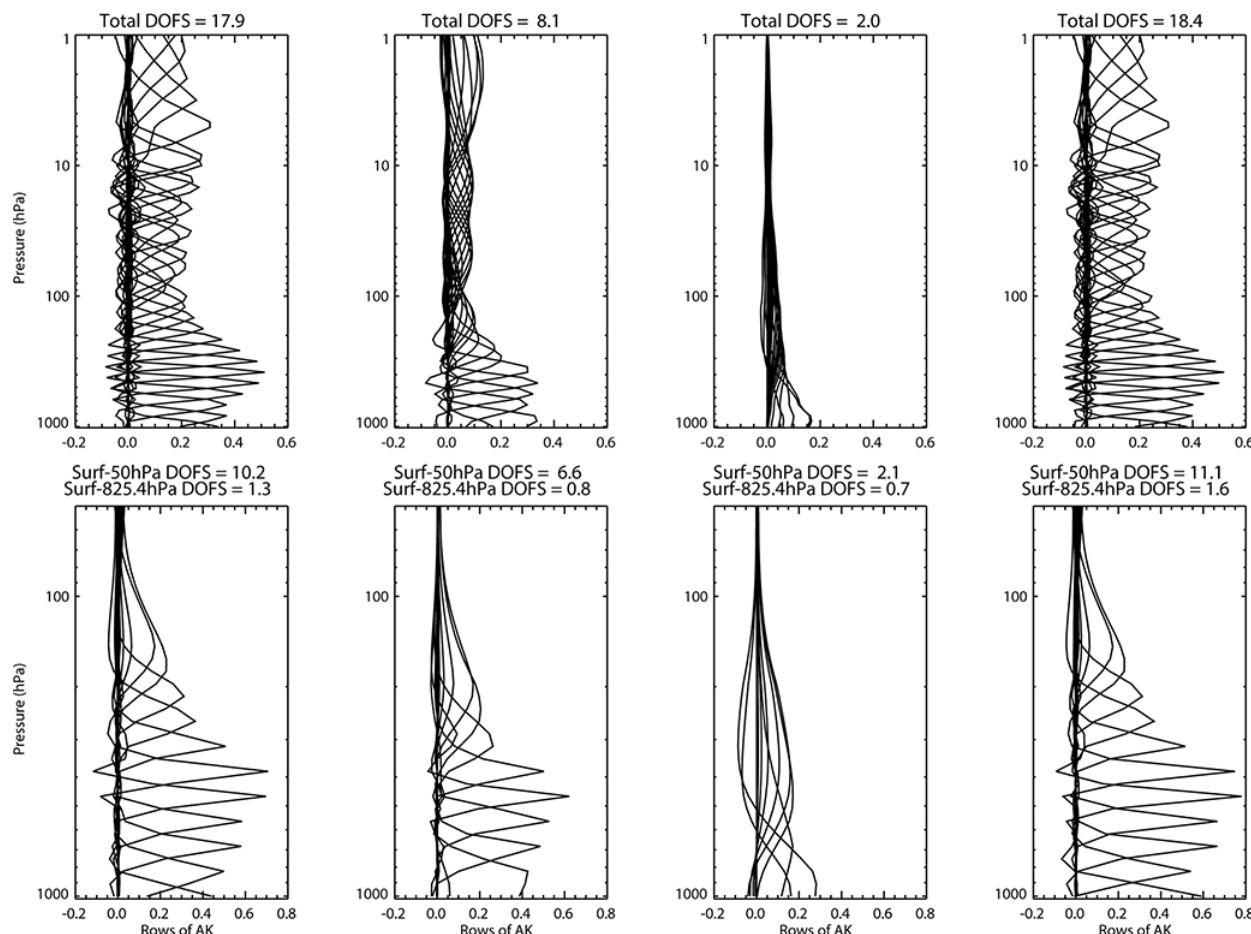
Figure 5. Plots of averaging kernel rows for (top) TATM and (bottom) H 2 O. The spectral ranges are (from left to right) VLWIR + LWIR, MWIR, SWIR, and VLWIR + LWIR + MWIR + SWIR. These results are for the Houston case.